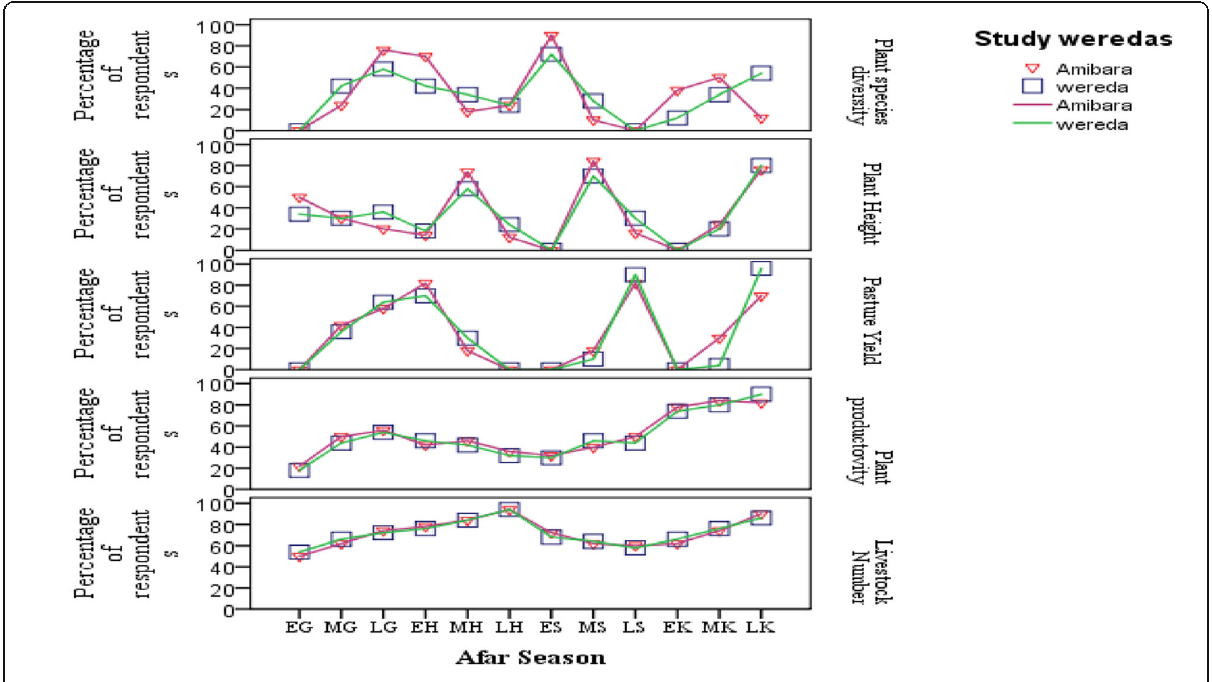
Fig. 1 The relationship between indicators of rangeland condition and Afar seasons in the study areas of Afar region,